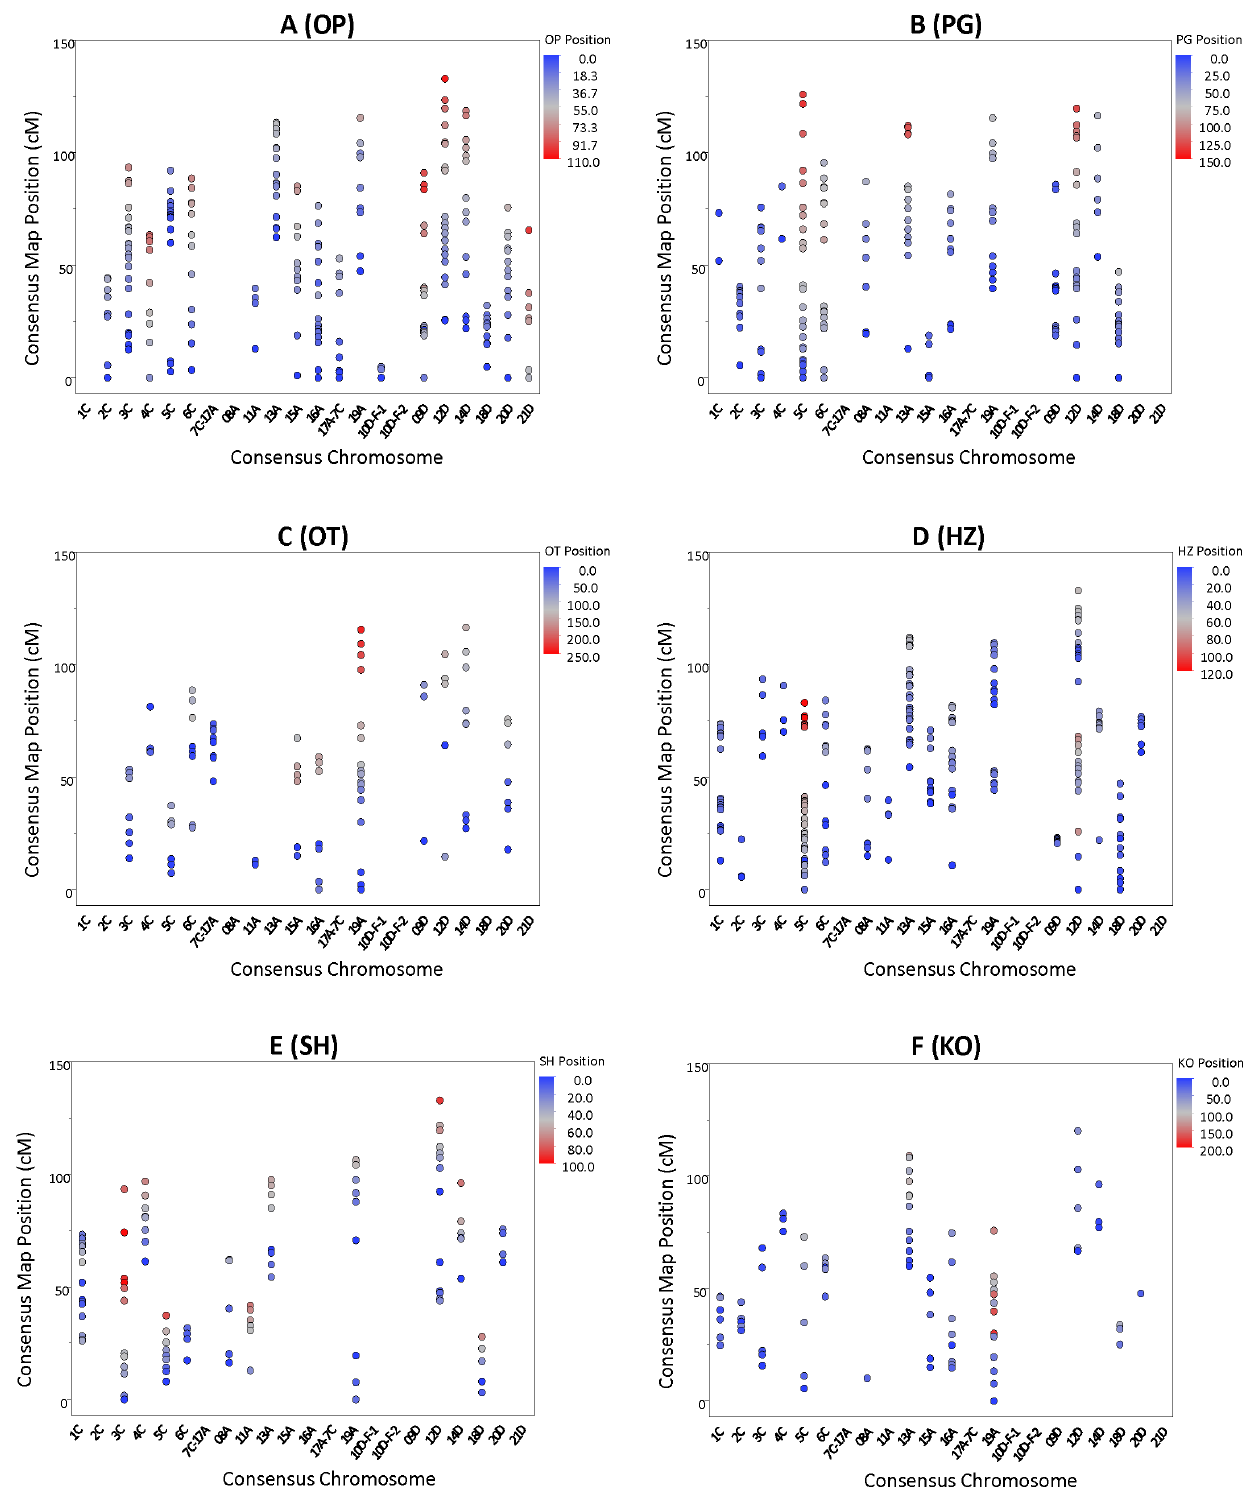
Figure 2. Marker density and positions for individual linkage maps (Otana/PI 260616, A; Provena/94197A1-9-2-2-2-5, B; Ogle/TAM O-301, C; Hurdal/Z-959-1, D; SolFi/HiFi, E; and Kanota/Ogle, F) in relationship to the consensus. Marker positions in the consensus map are indicated by the scales on the left axes; positions of each corresponding marker in the component maps are indicated by a color gradient described in the key.